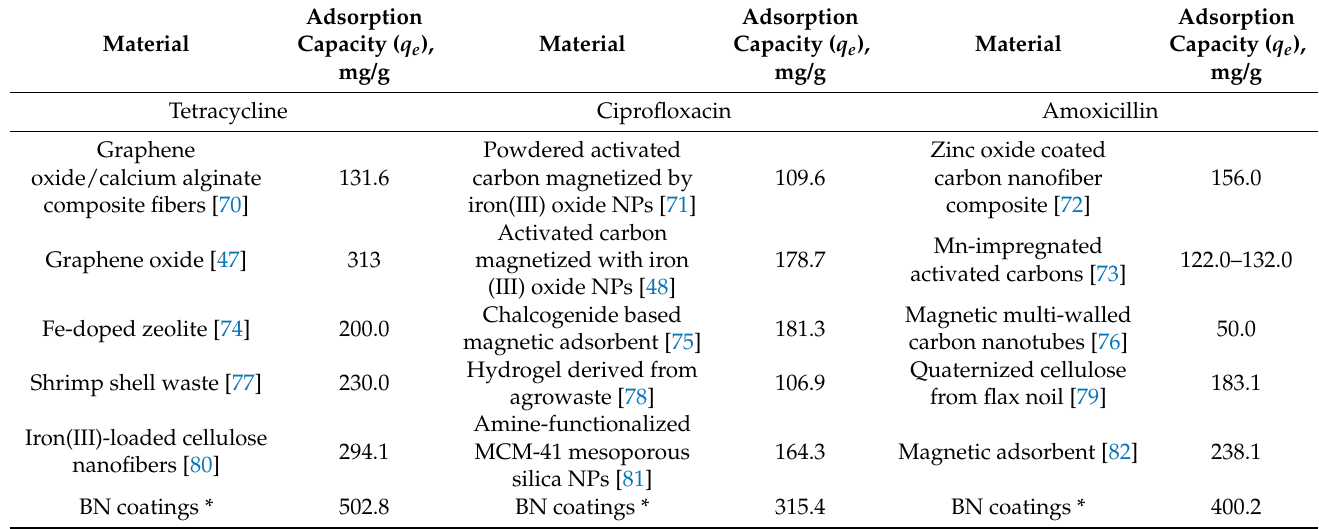
Table 3. Adsorption capacity of various materials in the purification of aqueous solutions from